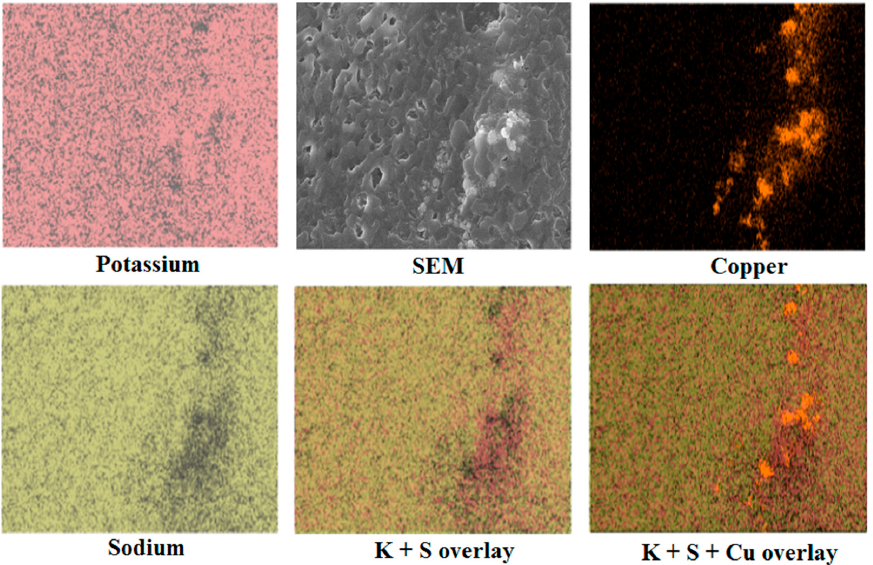
Figure 3. EDX mapping of potassium (red), sodium (yellow) and copper (orange) with several overlays to show the distribution of atoms.